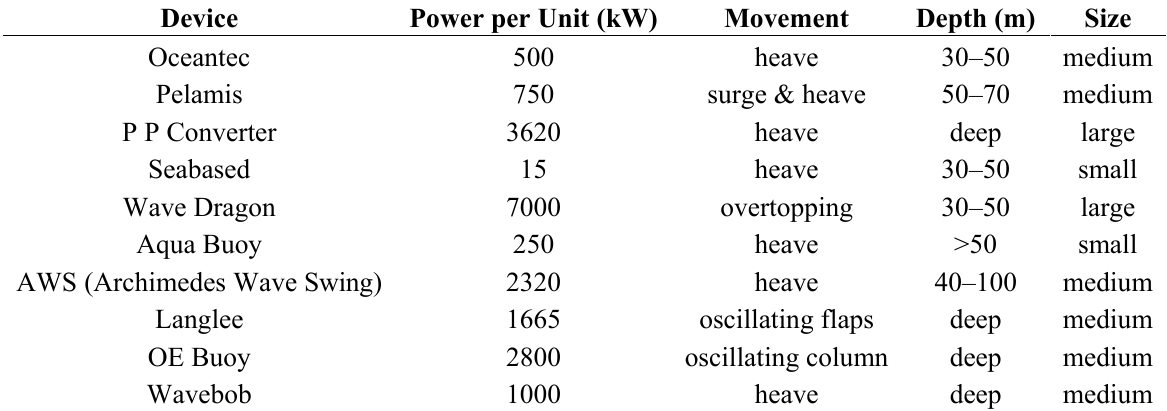
Table 1. Comparison of some basic characteristics of the devices considered in this